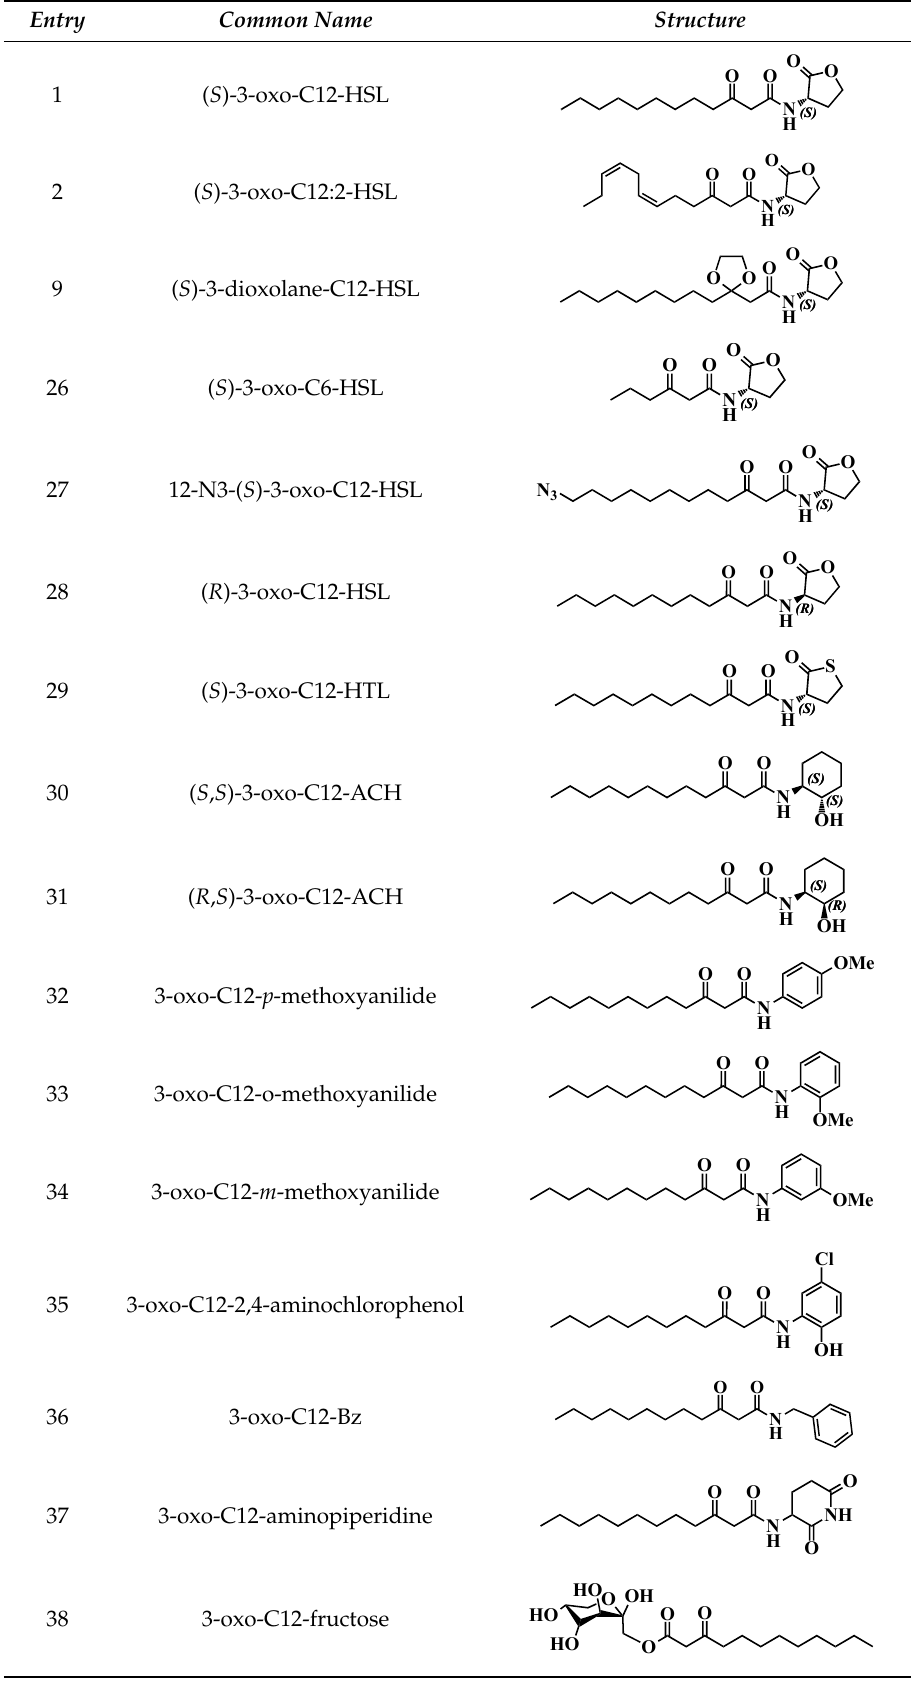
Table 1. Overview of the AHL analogues library.